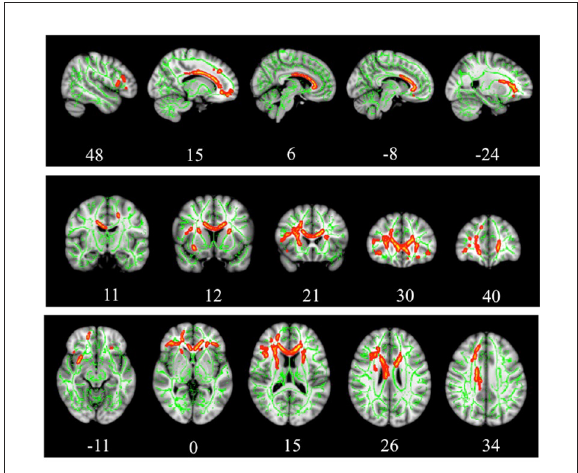
FIGURE1 TBSS analysis of white matter skeleton. Voxels demonstrating significantly ( p < 0.05) decreased FA values for the subjects with TBI compared with the control group are shown in red-yellow. Voxels were thickened into local tracts and overlaid on the white matter skeleton (green).